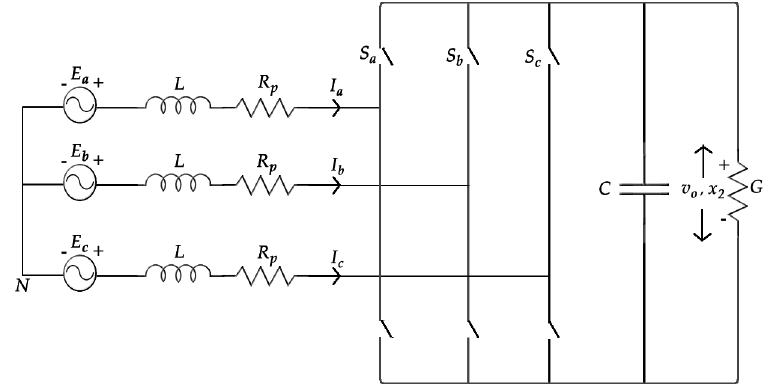
Figure A3. 3-phase AC-DC boost converter